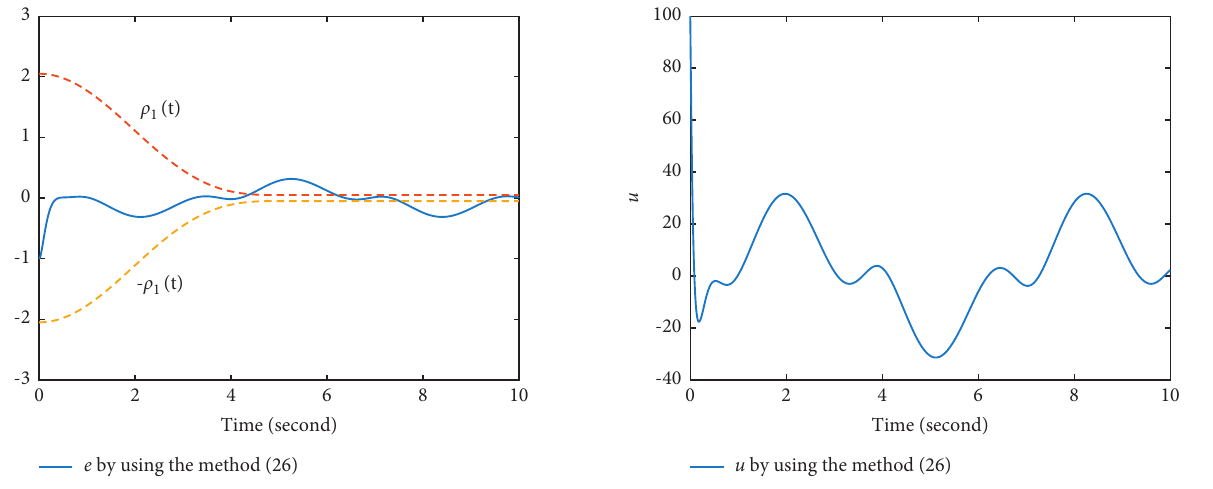
Figure 1: Time response trajectory of tracking error e by using method (26).